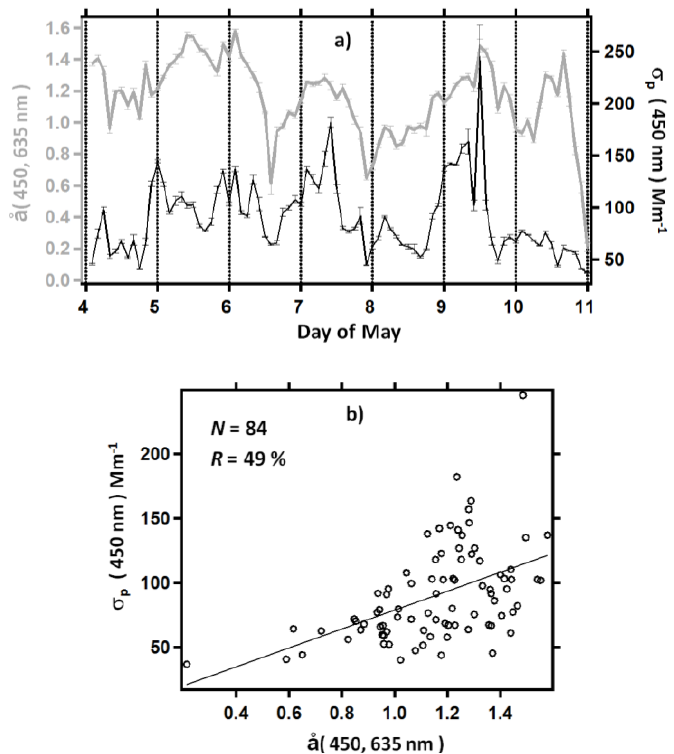
Figure 5. ( a ) The black and grey lines show the 2-hour averaged values of σ p (450 nm) and å (450, 635 nm), respectively, retrieved from nephelometer measurements, from 4 to 10 May 2015. Error bars represent the SEMs; ( b ) σ p (450 nm) versus å (450, 635 nm) plot. The solid line represents the best fitting regression line, N is the total number of data, and R represents the linear correlation coefficient.